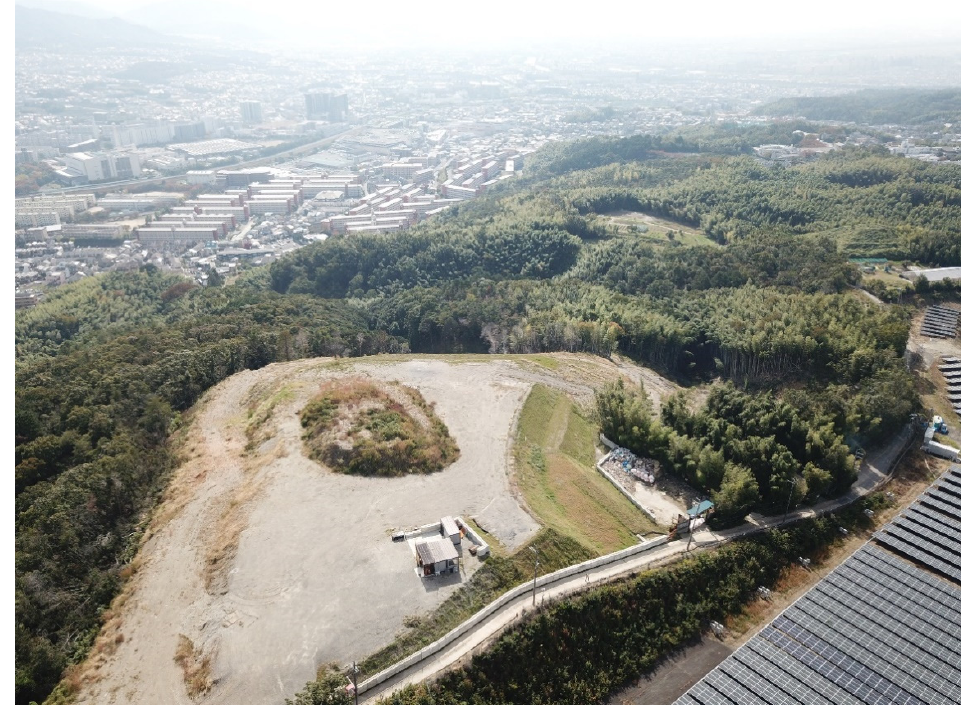
Figure 1. An inland private fill site in central Japan showing solar panels and located a close distance to a residential area (image acquired by the authors on 7 November 2019 using a DJI Mavic Pro drone).